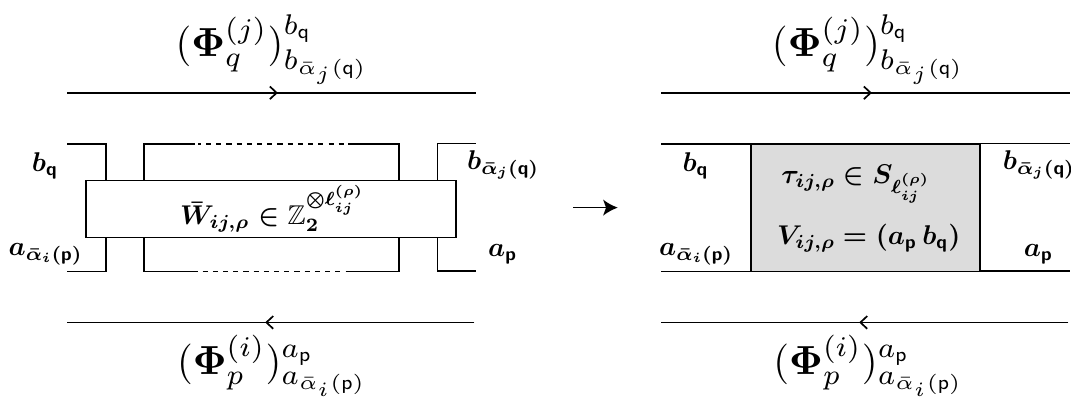
Figure 9 . Rewriting the open two-point function in (cid:12)gure 7 in terms of ( V; (cid:28) ). The color indices at the four end-points are denoted by